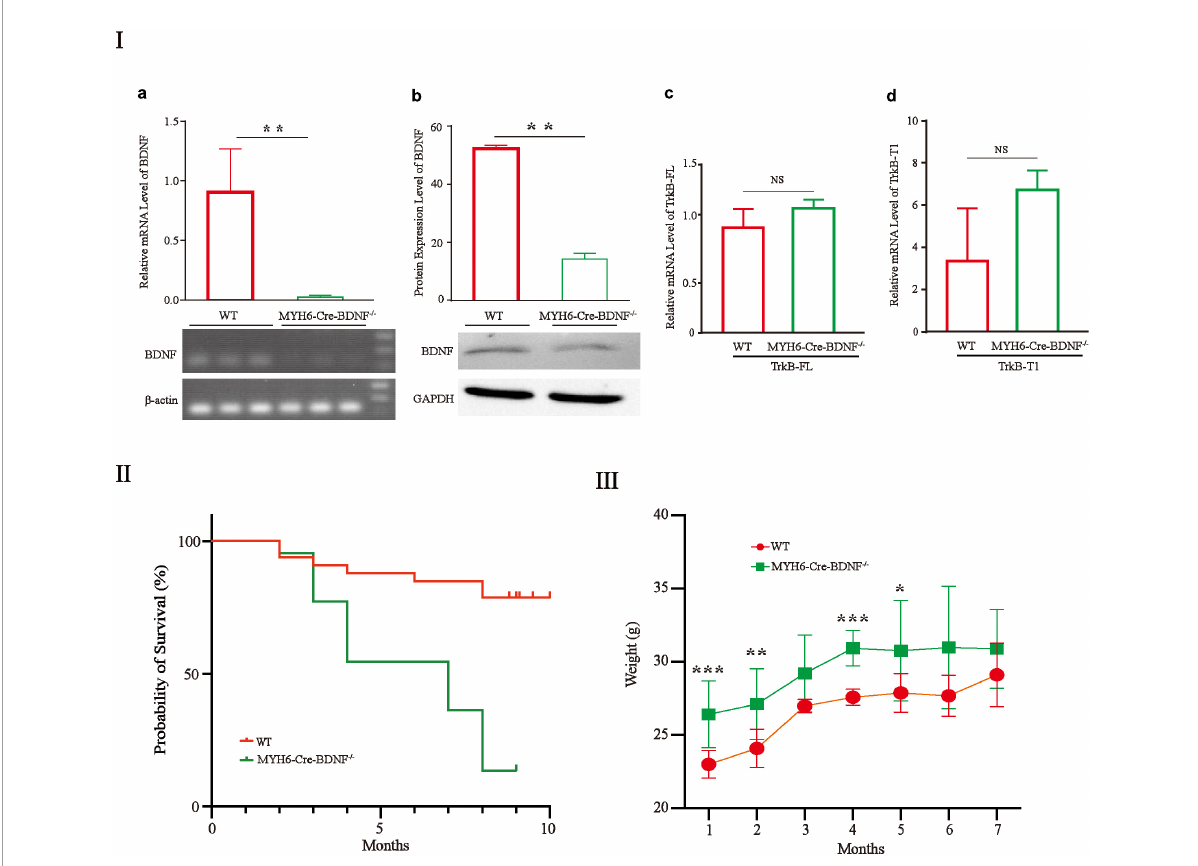
FIGURE1 The one-year survival rate of MYH6-Cre-BDNF − / − mice is significantly reduced: (I) The expression of BDNF at the gene (a) and protein levels (b) in MYH6-Cre-BDNF − / − cardiomyocytes was significantly lower than that in WT cardiomyocytes from littermates. ∗∗ p < 0.01, n = 3. In addition, the expression of the BDNF receptors TrkB-FL and TrkB-T1 in MYH6-Cre-BDNF − / − cardiomyocytes was not significantly different from that in WT cardiomyocytes (c,d) . (II) The one-year survival rate of MYH6-Cre-BDNF − / − mice was significantly lower than that of WT mice, p < 0.01. (III) The body weights of MYH6-Cre-BDNF − / − mice in 1-, 2-, 4-, and 5-month-old of age were significantly higher than those of WT mice. * p < 0.05, ** p < 0.01, *** p < 0.001, n = 12 for the 1-month-old WT and MYH6-Cre-BDNF − / − groups respectively. n = 10 for the 2-month-old WT and MYH6-Cre-BDNF − / − groups respectively. n = 5 and 7 for the 3-month-old group WT and MYH6-Cre-BDNF − / − groups. n = 10 and 3 for the 4-month-old WT and MYH6-Cre-BDNF − / − groups. n = 8 for the 5-month-old WT and MYH6-Cre-BDNF − / − groups. n =